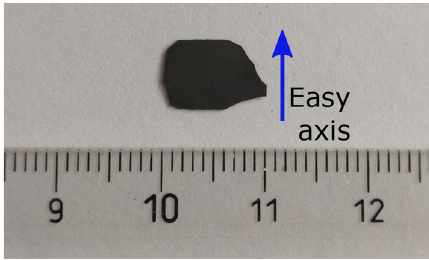
Figure 3. Photographic image of the NdFeB sintered magnetic sheet. The sintered magnet is characterized by big and isotropic grains of few micrometer in size. The sample is 0.15 mm thick and coated with 0.5 nm tantalum. The blue arrow indicates the easy axis of the magnetization. The scale in the background is expressed in